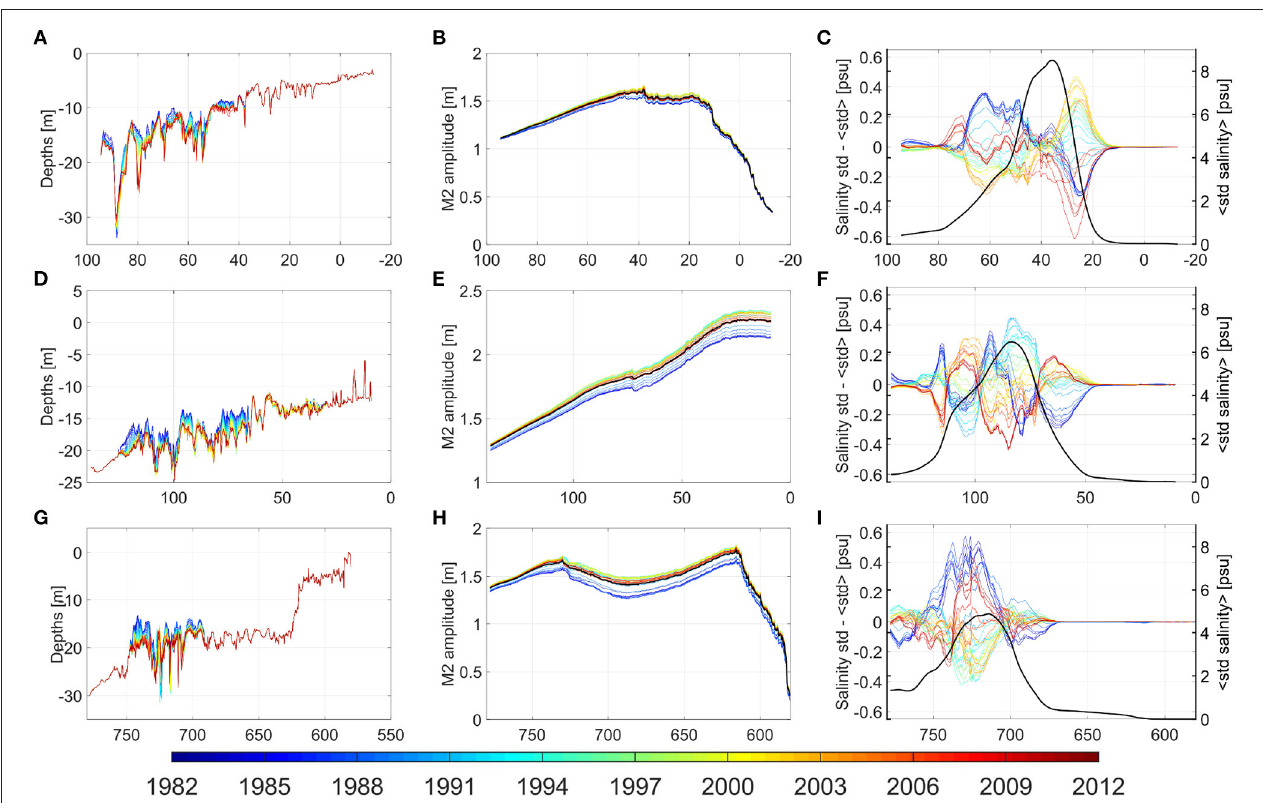
FIGURE 10 | Bathymetric changes in the Ems (A) , Weser (D) , and Elbe (G) Estuaries. The corresponding amplitudes of the M2 tide are shown in the middle (B,E,H) , and the variability of the sea surface salinity is shown on the right. The individual colors represent individual years. Wherever, the bathymetry in the AufMod data does not cover some areas, the color is red. The black lines in the figures in the middle and on the right show the mean of the standard deviations (M2 amplitudes in the middle panels) for all experiments with time-referenced bathymetry. The colored lines in (C,F,I) depict the difference between the standard deviation in the individual experiment and the mean standard